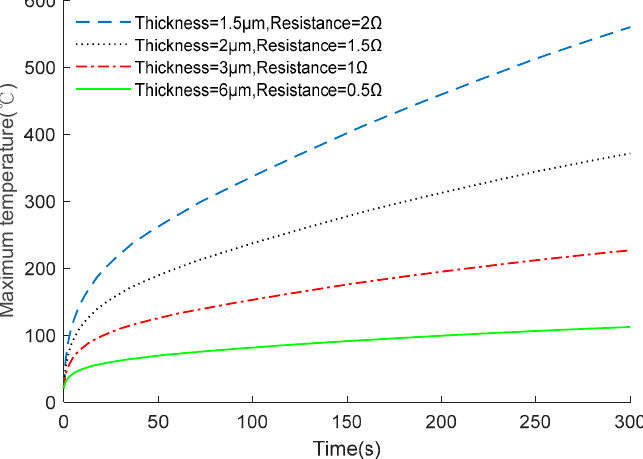
Figure 11. Output characteristics of EC elements with different resistance values.